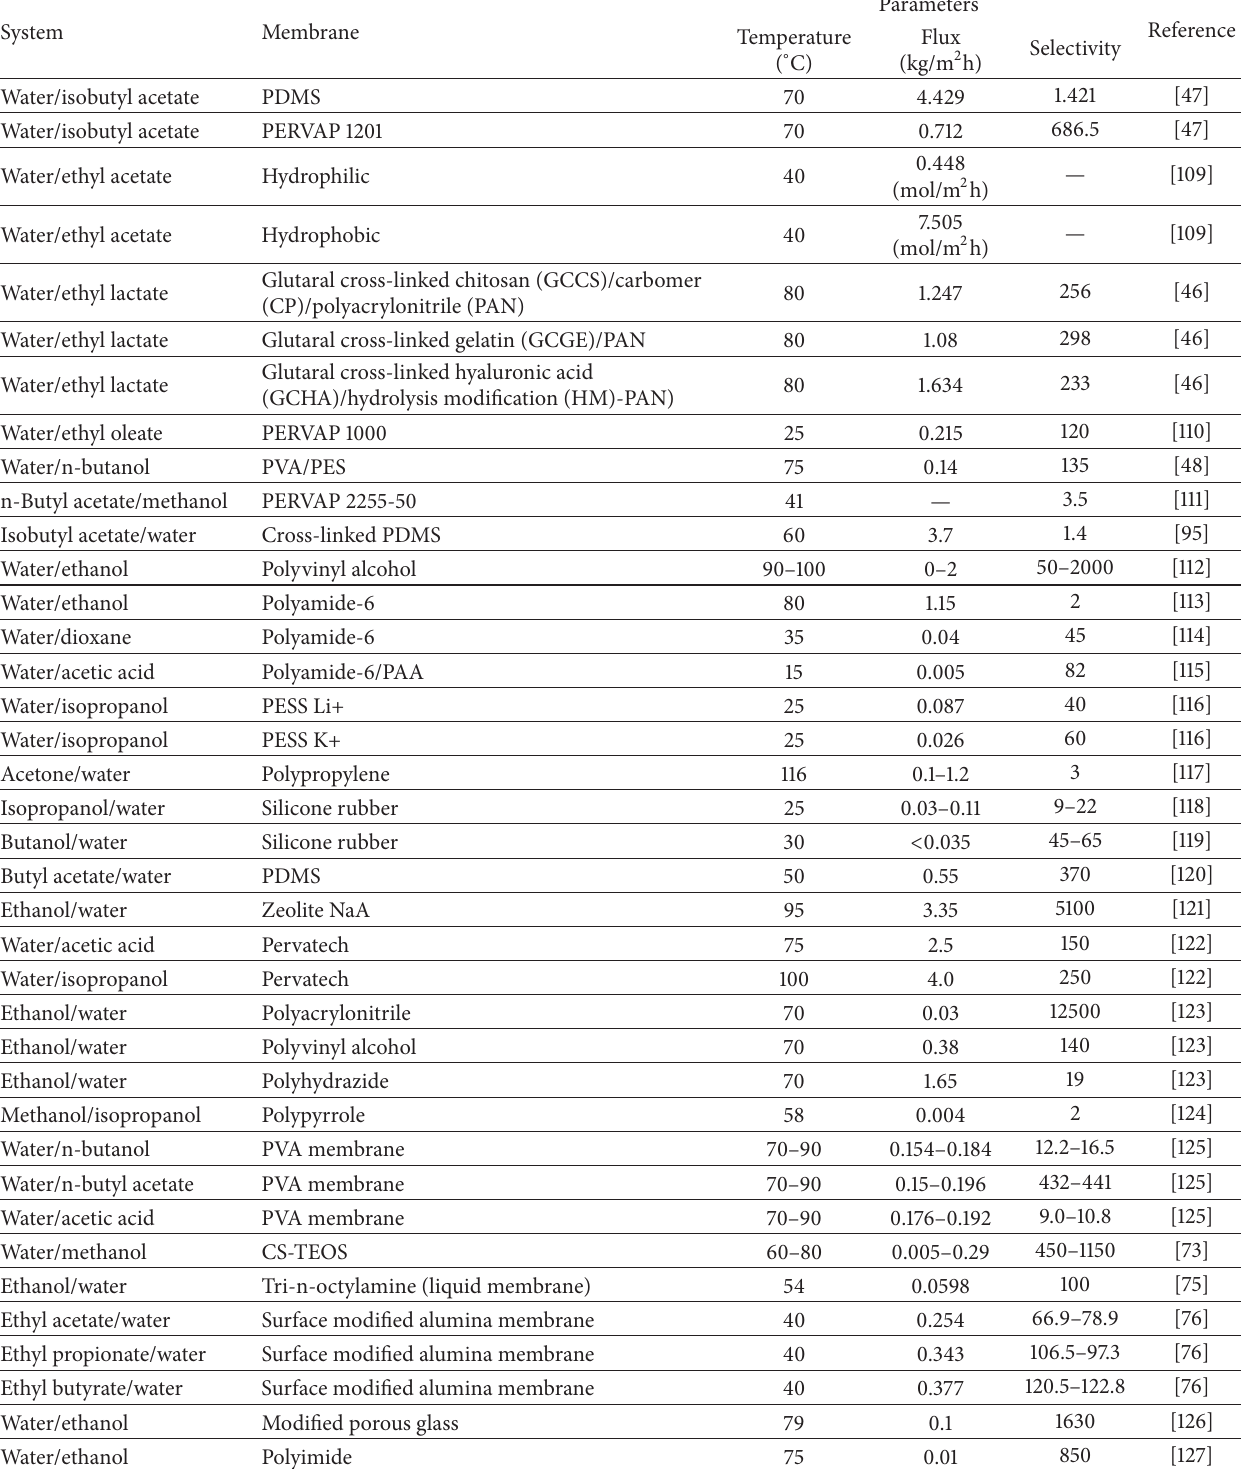
Table 2: Overview of membrane performance parameters of different pervaporation